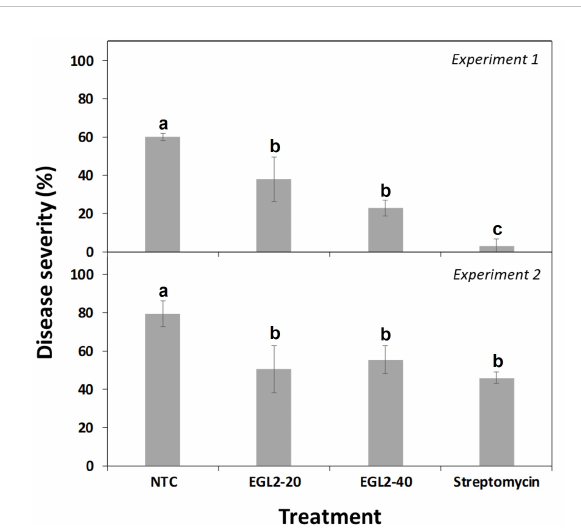
FIGURE 3 Effect of spray application of EGL2 on infection severity by E. amylovora on pear plant leaves. Two independent assays were performed, and EGL2 was applied by spraying 24 h before pathogen inoculation. Disease severity was evaluated on pear plants after 8 days from pathogen inoculation (10 7 CFU/ml). Values correspond to the mean disease severity of three replicates of three plants per treatment. Standard errors are indicated on bars. The effect of treatments was signi fi cant according to ANOVA (p<0.001 for experiment 1 and p=0.002 for experiment 2). Different letters between treatments indicate signi fi cant differences between disease severities according to Tukey ’ s test (P ≤